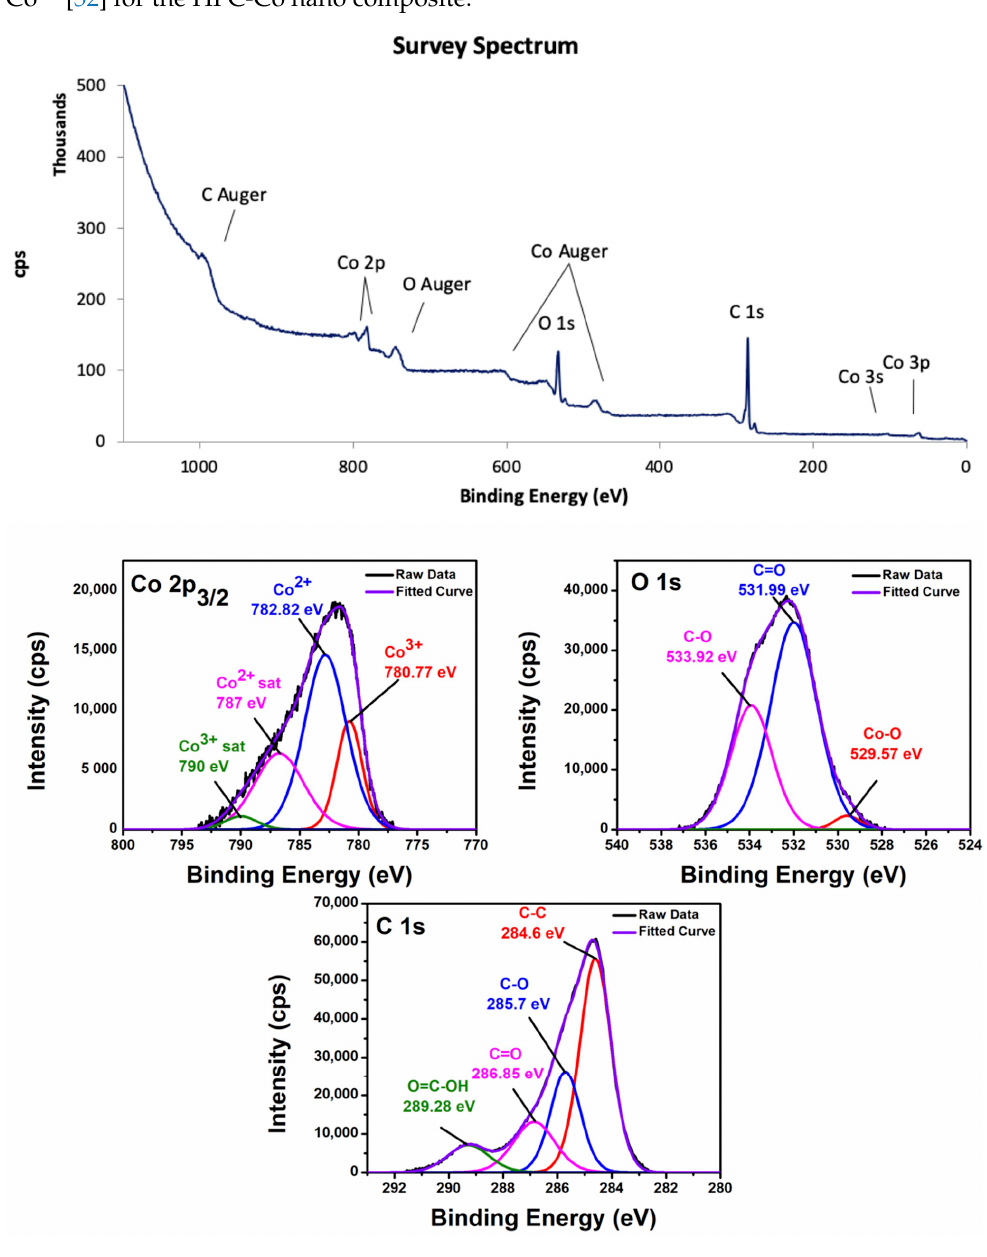
Figure 8. XPS spectrum of HPC-Co (1) and the high-resolution spectra of Co, O, and C. 3.2. Electrochemical Behavior of HPC-Co and HPC-CoO Modified Electrodes Cyclic voltammetry (CV) was conducted in 0.1 M NaOH solution to probe the elec- trocatalytic activity of HPC-Co and HPC-CoO casted on glassy carbon electrodes. The CV was measured in the potential window ( − 0.2 to 0.8 V vs. Ag/AgCl) and a scan rate of 25 mV/s in the absence and presence of 1.09 mM fructose. Two redox peaks are observed in the absence of fructose (Figure 9). The first redox couple labeled as (I/II) is attributed to the reversible transition between CoO x and CoOOH, (Equation (1)). The second re- dox couple labeled (III/IV) is attributed to further oxidation of cobalt to CoO 2 at